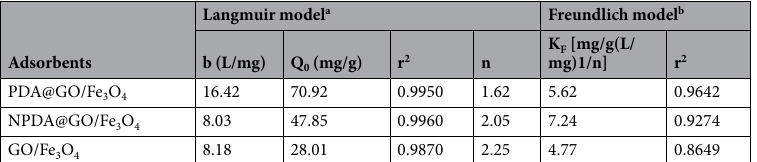
Table 1. The fitting parameters of the Langmuir and Freundlich equations for the adsorption of SAR on the PDA@GO/Fe amount (mg/g) of SAR on the nanoparticles at equilibrium and the maximum capacity, respectively. C e was the equilibrium concentration of SAR. b and K F were the Langmuir and Freundlich constants, respectively, and n was the Freundlich exponent.